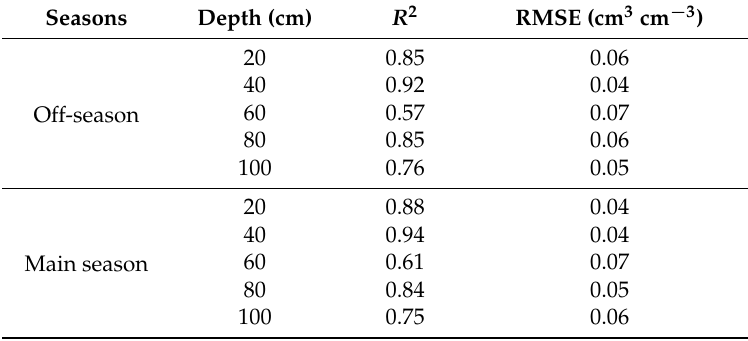
Table 5. The comparison between simulated and observed soil water